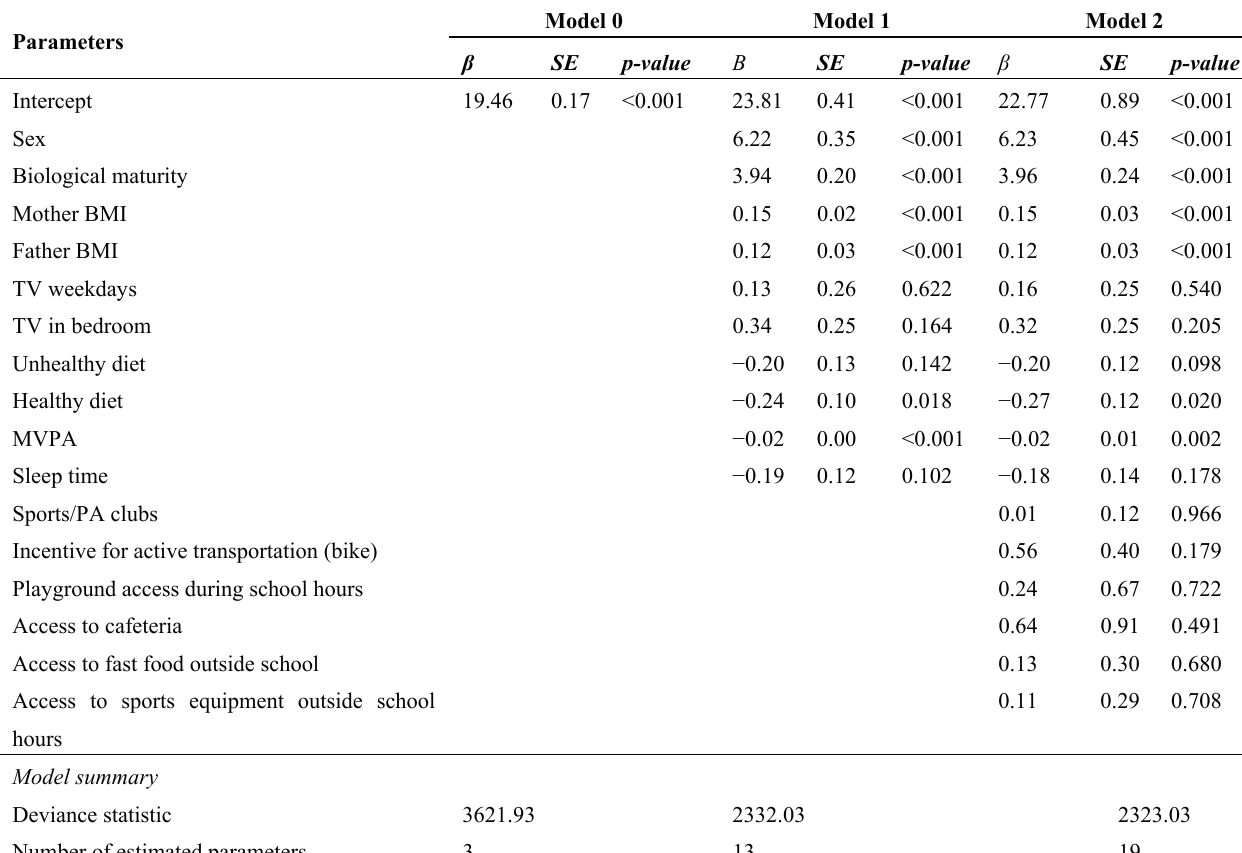
Table 3. Multilevel modelling results: regression estimates ( β ), standard-errors (SE), and p -values for children and school characteristics influencing BMI